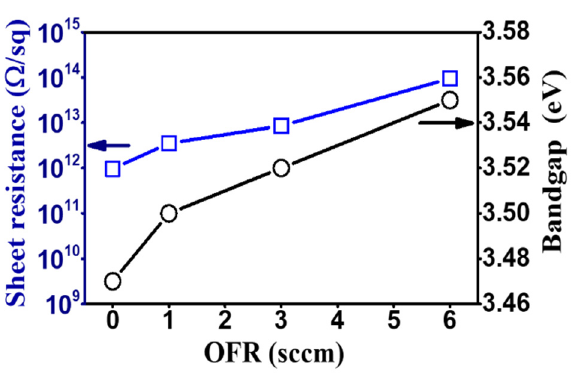
Figure 6. The variation of sheet resistance and bandgap energy of the as-deposited a -IGZO films with various oxygen flow rates.